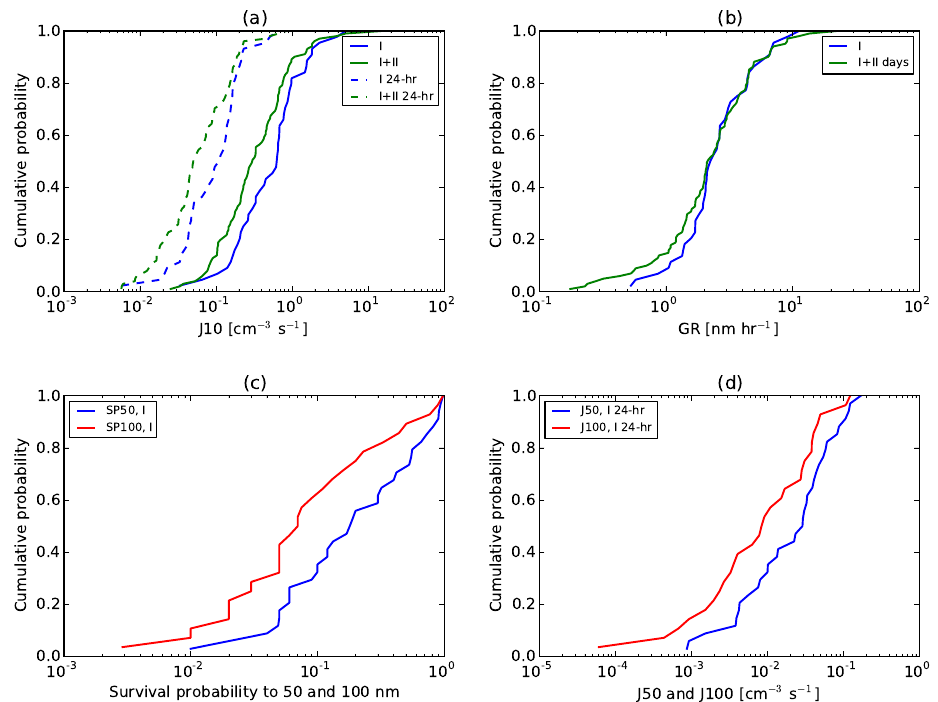
Figure 3. Cumulative probability distributions of various nucleation and growth metrics from the full year. Panel (a) : J10 rates for both I days and I + II days. Solid lines show the rates averaged only over the period where nucleation was occurring. Dashed lines show the rates averaged over the full day. Panel (b) : growth rates for both I days and I + II days. For the following panels, only I days are shown as we do not trust the estimates of survival probability for II days. Panel (c) : survival probability to 50 and 100nm. Panel (e) : 24h mean production rate of 50 and 100nm particles. Table 1. Means and medians of nucleation, growth and CCN-formation parameters across all days of each event class.